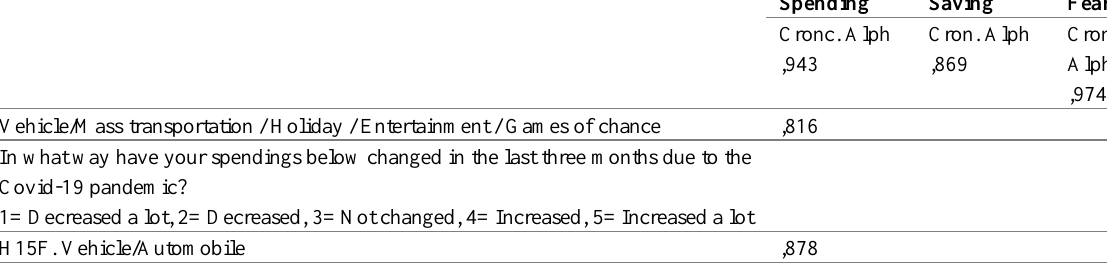
Spending Saving Fear Cronc. Alph ,943